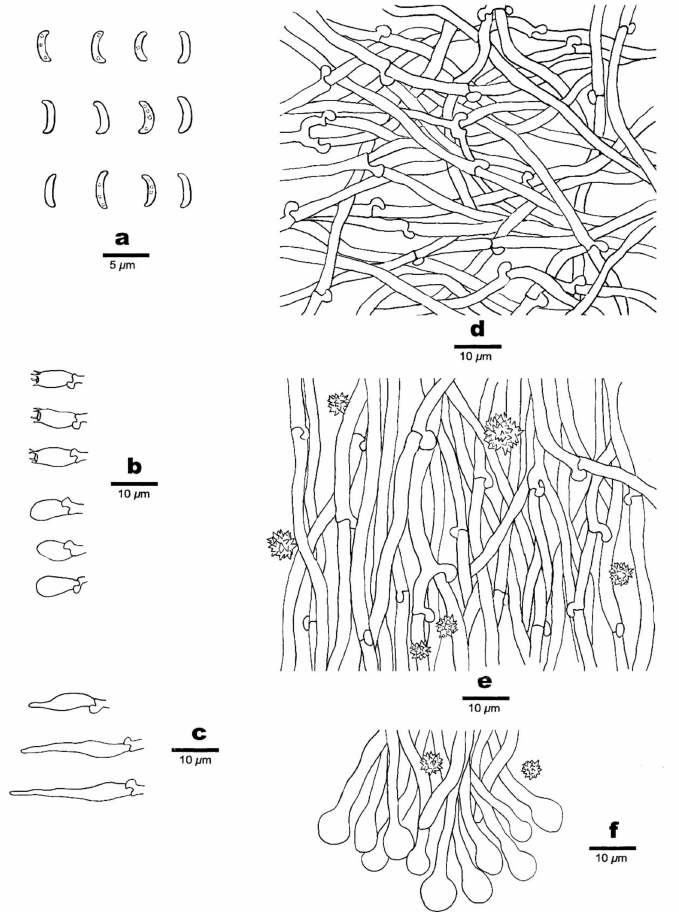
Figure 11. Microscopic structures of Sidera roseo-bubalina (holotype, Dai 11277). ( a ) Basidiospores. ( b ) Basidia and basidioles. ( c ) Cystidioles. ( d ) Hyphae from subiculum. ( e ) Hyphae from trama. ( f ) Hyphae at dissepiment edge. Drawing by Meng